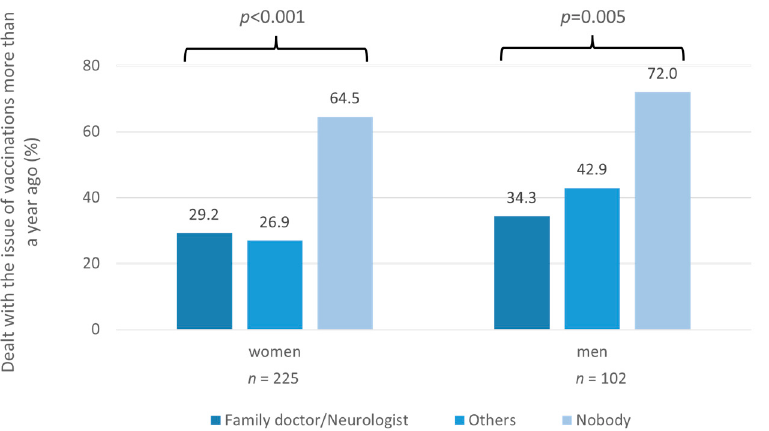
Figure 4. Vaccination interest of MS patients stratified by sex and by persons who regularly checked their vaccination card. Women and men were separately examined for an association between their interest in vaccinations and the person checking their vaccination card. Of the men who did not have their vaccination card checked by anyone, about 70% had not dealt with the issue of vaccinations within the past year (chi-squared test: p = 0.005). n —number of patients; p — p